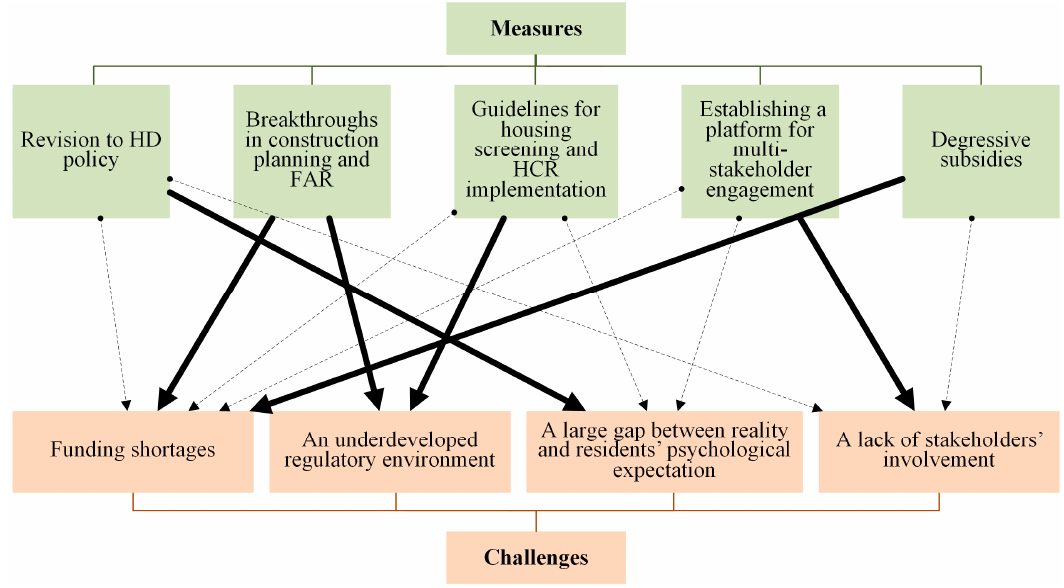
Figure 3. Corresponding relationships between measures and